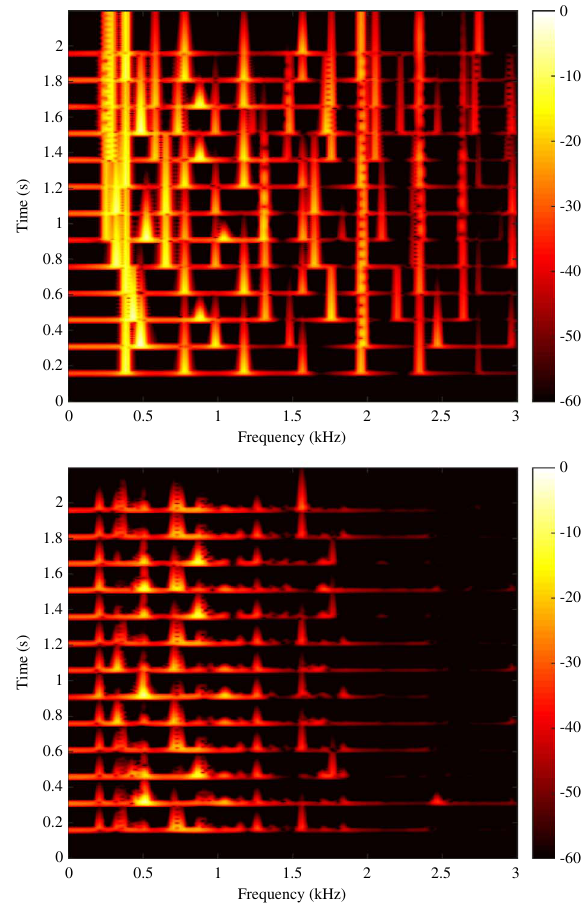
Figure 12. Spectrograms to illustrate modal synthesis: (a) string modes only; (b) body modes